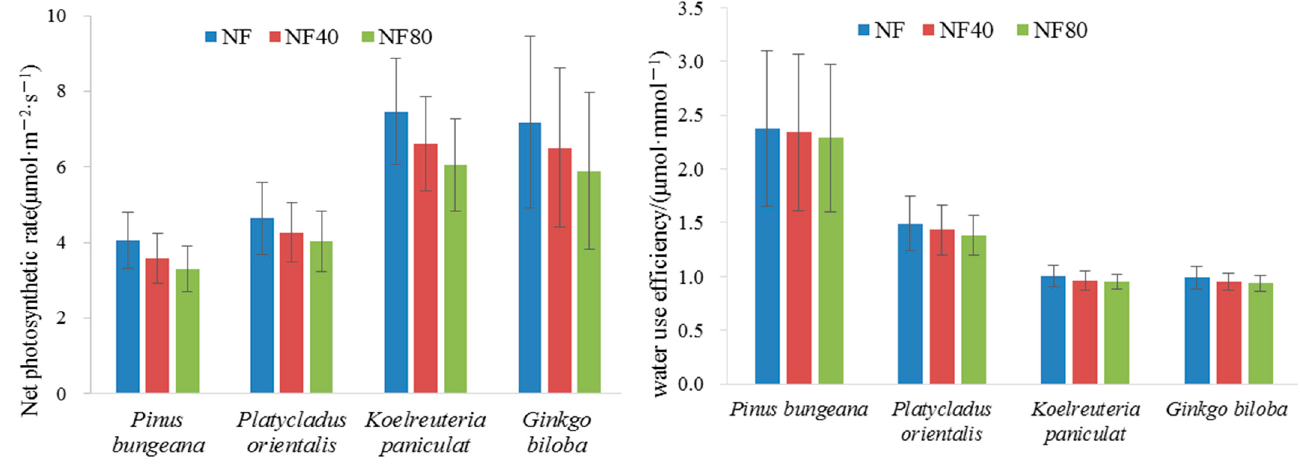
Figure 4. Variation of net photosynthetic rate and water-use efficiency of trees under different ozone concentrations.